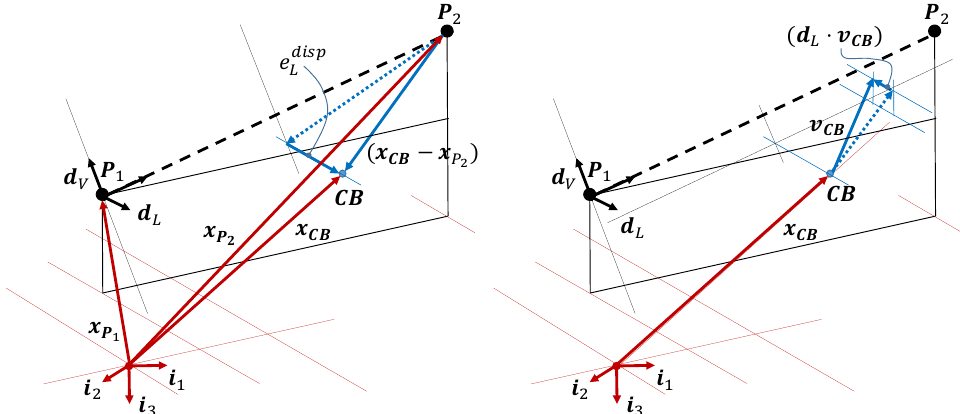
Figure 7. Sketch of beam-tracking measurements for lateral guidance. ( Left ) definition of e disp ( Right ) computation of d L · v CB